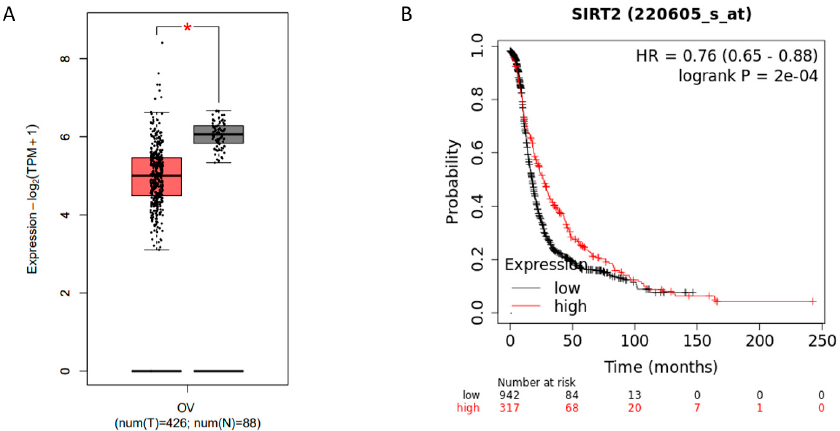
Figure 2. The A2780/S and A2780/CP cells were treated with cisplatin (2 μ M) for 24 and 48 h. The intracellular reactive oxygen species (ROS) levels were measured through staining by flow cytometric assay using dihydroethidium (DHE) ( A ) and 2,7-dichloro-dihydrofluorescein diacetate (DCFH-DA) ( B ) staining. The A2780/S and A2780/CP cells were treated with cisplatin (2 μ M) only or cotreated with NAC. Cell viability was accessed using an MTT assay ( B ) and cell apoptosis was determined using flow cytometry ( C ). Results are shown as mean ± SEM (* p ≤ 0.05, ** p ≤ 0.01, *** p ≤ 0.001).